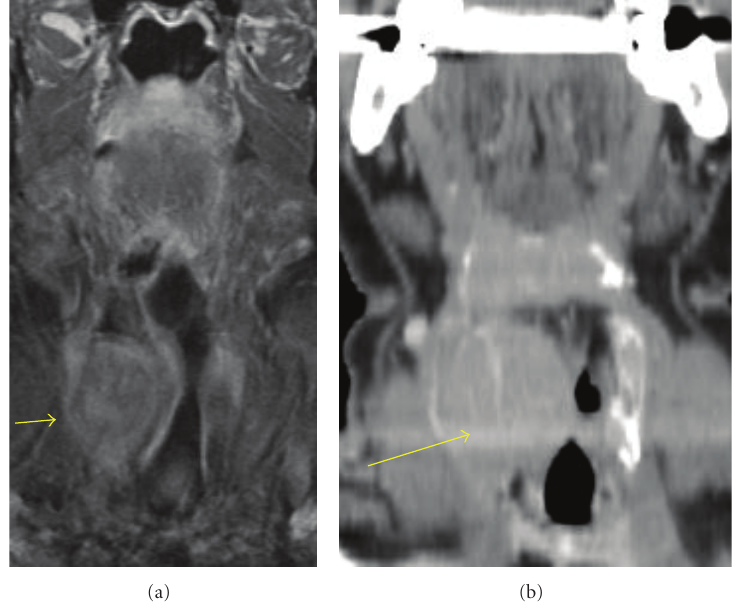
Figure 2: Coronal MRI (a) and coronal CT (b); postcontrast homogeneous enhancement of the